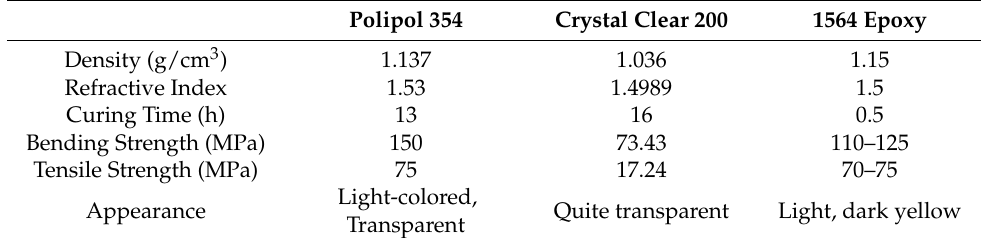
Table 1. Properties of matrix materials [23].